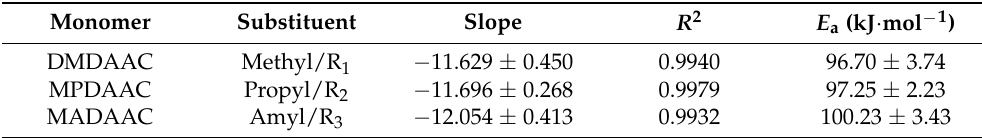
Figure 3. Relationship between ln k and 1/ T . Table 2. Experimental results of measuring the polymerization activation energy E a of different monomers.